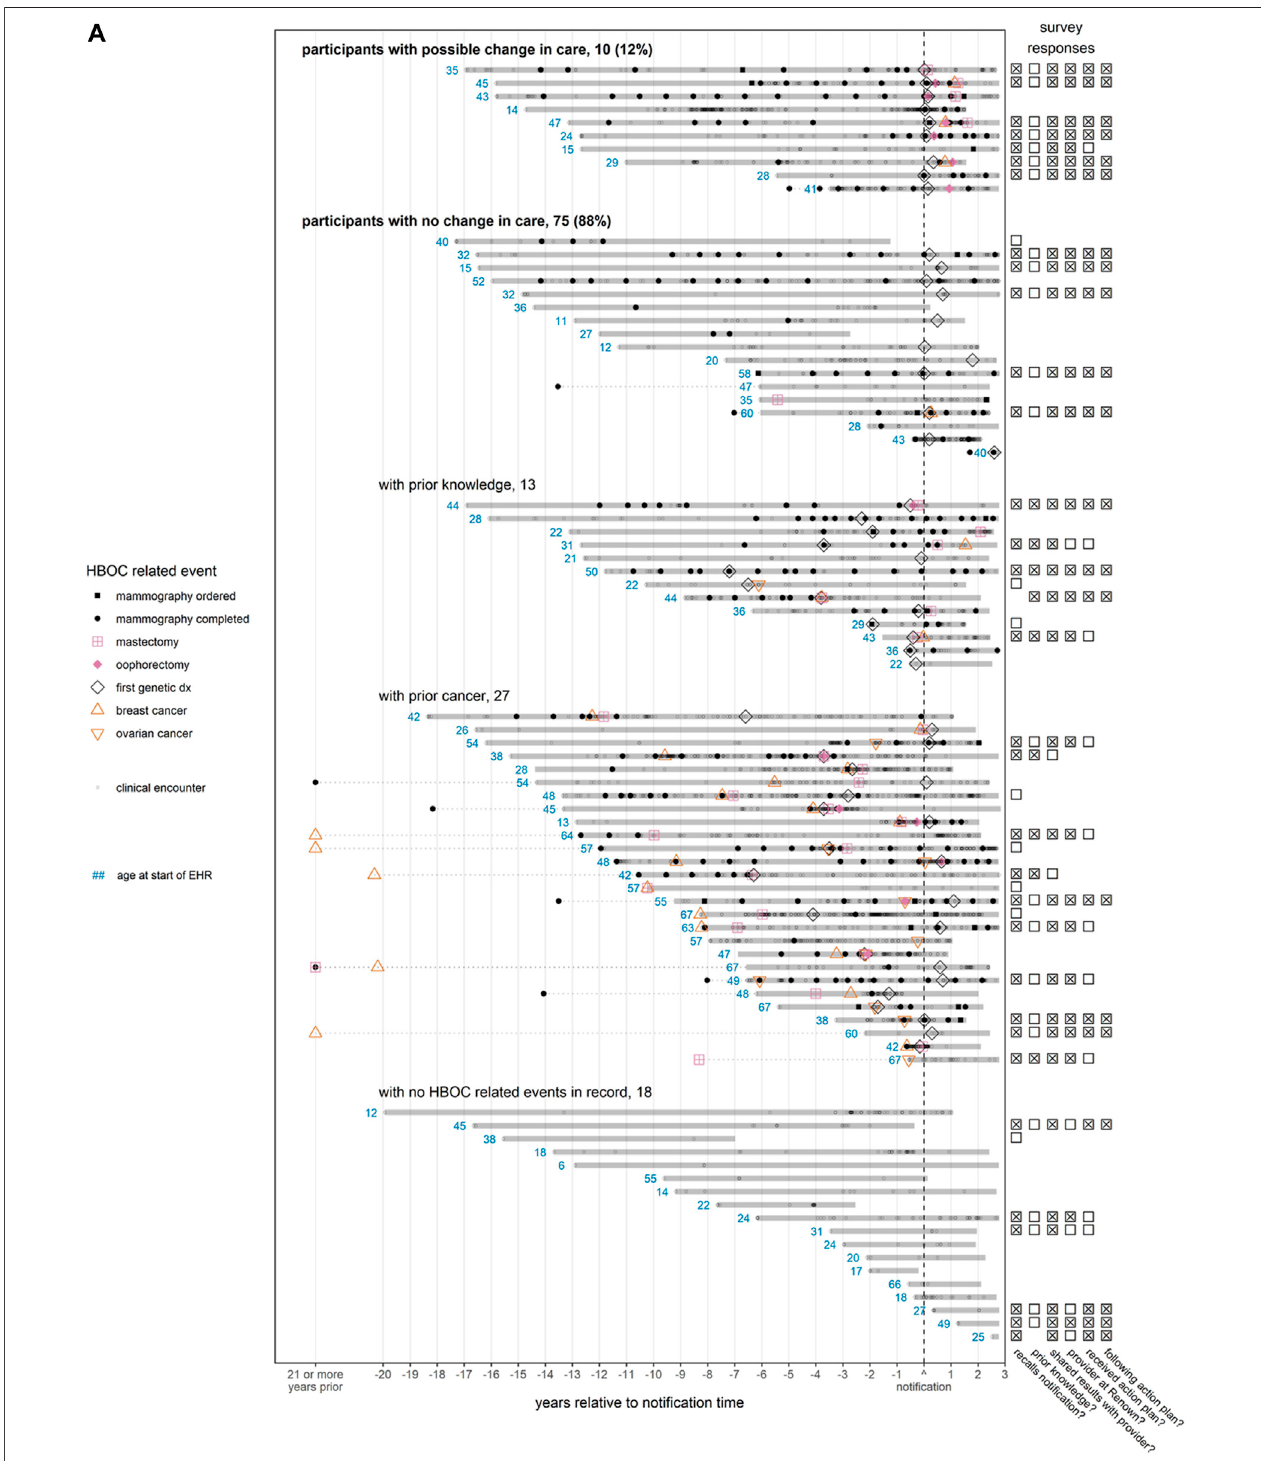
FIGURE2|(A)(B)(C) — EHRtimelinesand surveyresponsesforparticipants noti fi edof fi ndings.Each solidhorizontallinerepresents adistinctparticipant medical record,withthedurationofthemedicalrecordrelativetotheparticipant ’ snoti fi cationdateindicatedbythespanoftheline.Apatient ’ smedicalrecordisde fi nedtobegin with patient ’ s fi rst record (procedure, diagnosis, or clinical encounter) and to end at the maximum date of the database (8/23/2021) or 1.5 years after the patient ’ s last record, whichever comes fi rst. If an event recorded in the notes occurs outside ofthis timespan, itis linked to the remainder of the patient record with a dotted line. To preserve space, any event in the notes occurring at least 21 years prior to noti fi cation is marked on the x -axis as occurring “ 21 or more years prior ” . The “ fi rst genetic